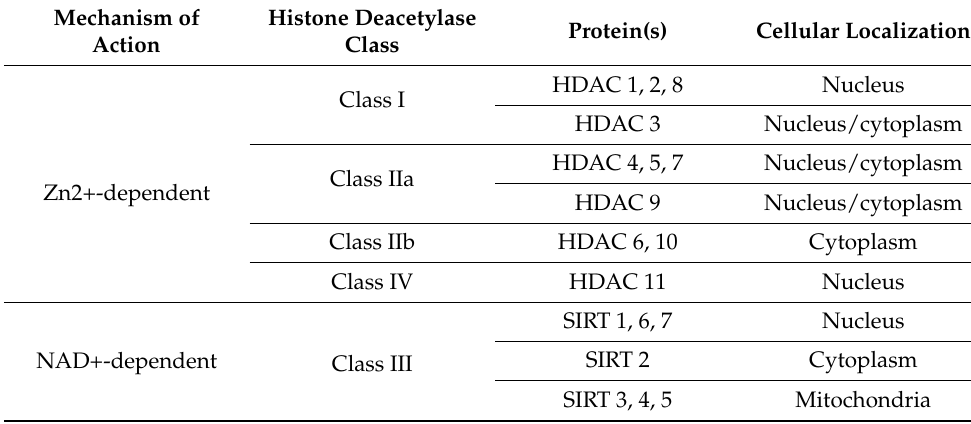
Table 1. Classification and cellular localization of histone